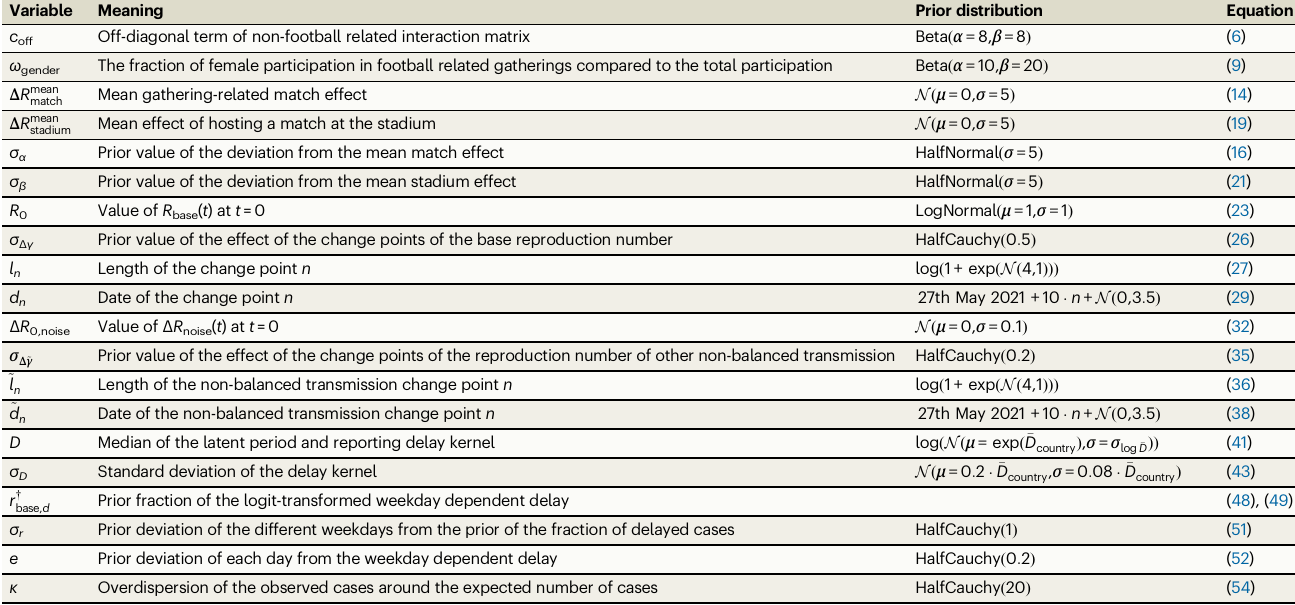
Table 2 | Prior distributions